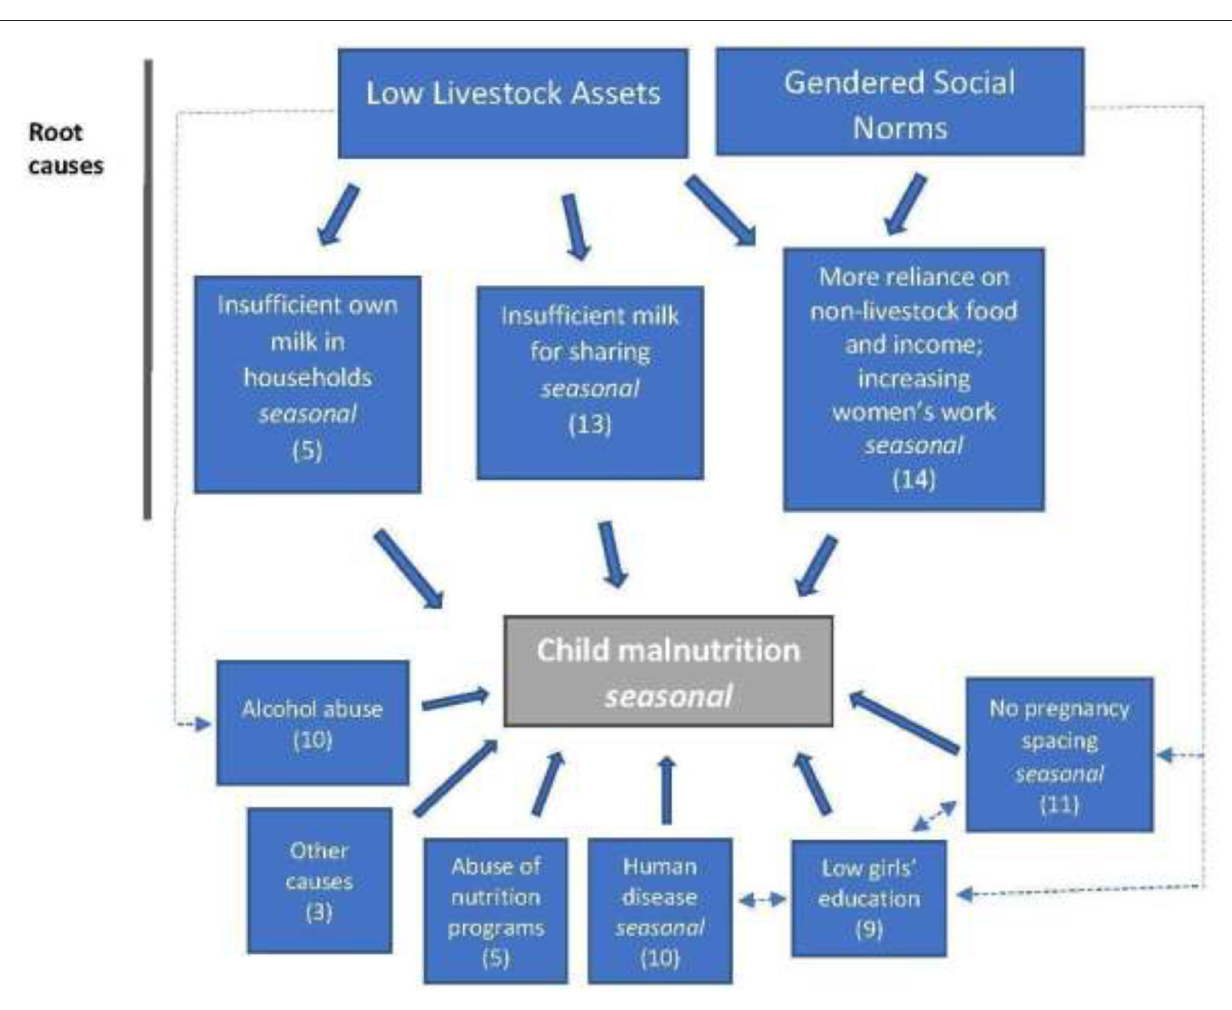
Frontiers in Veterinary Science |